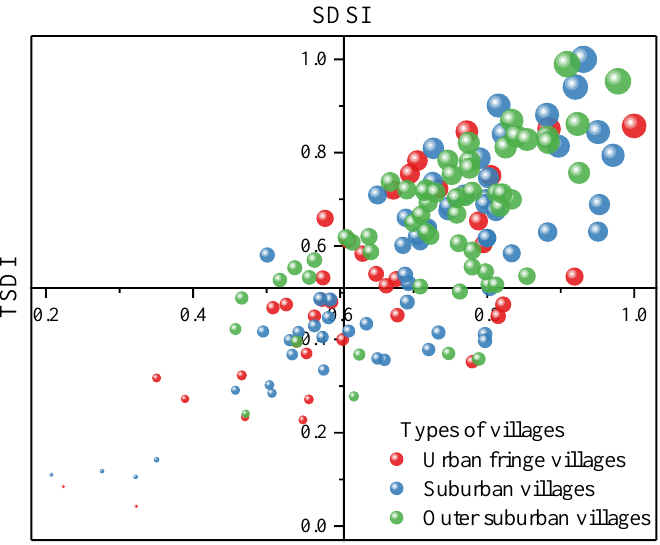
Figure 4. Statistical analysis of TDSI, SDSI, and SDHJ of various village types.